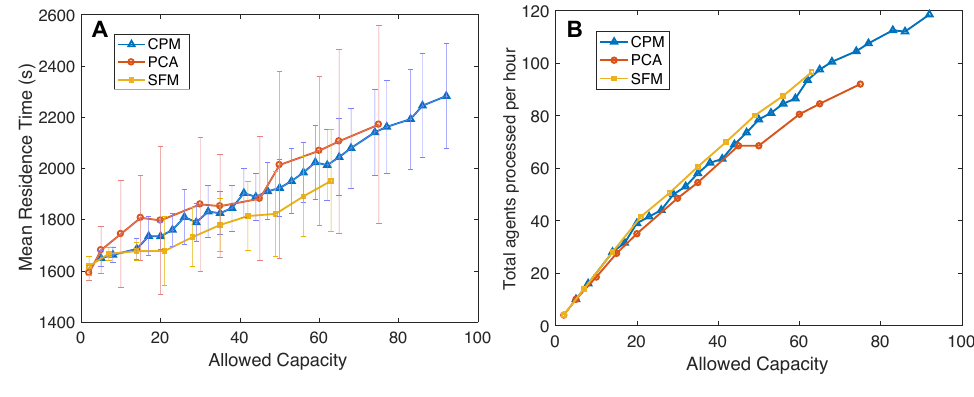
Figure 5: A: Mean residence time of agent as a function of occupation, for three different operational models. Error bars indicate one standard deviation. B: Number of agents processed per hour for the entire two-hour simulations, and also for the different operational models.